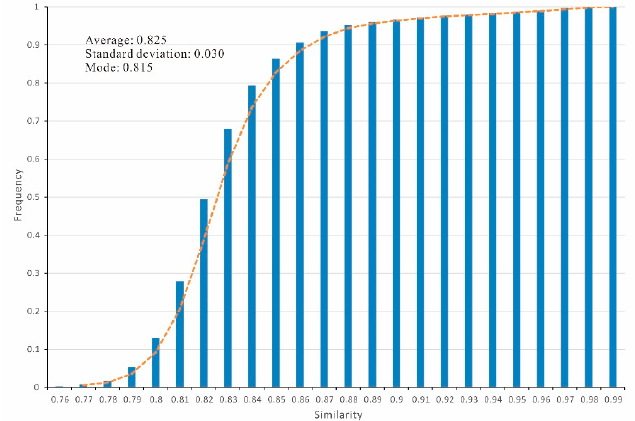
Figure 14. MPS-2 reproduces the cumulative frequency of similarity of similar geological patterns in training image TI-2.